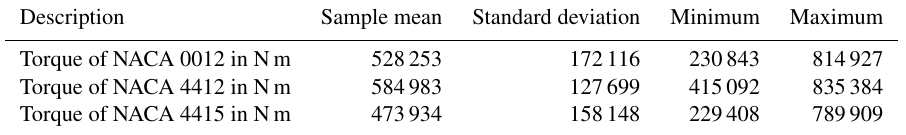
Table 5. Data variables for